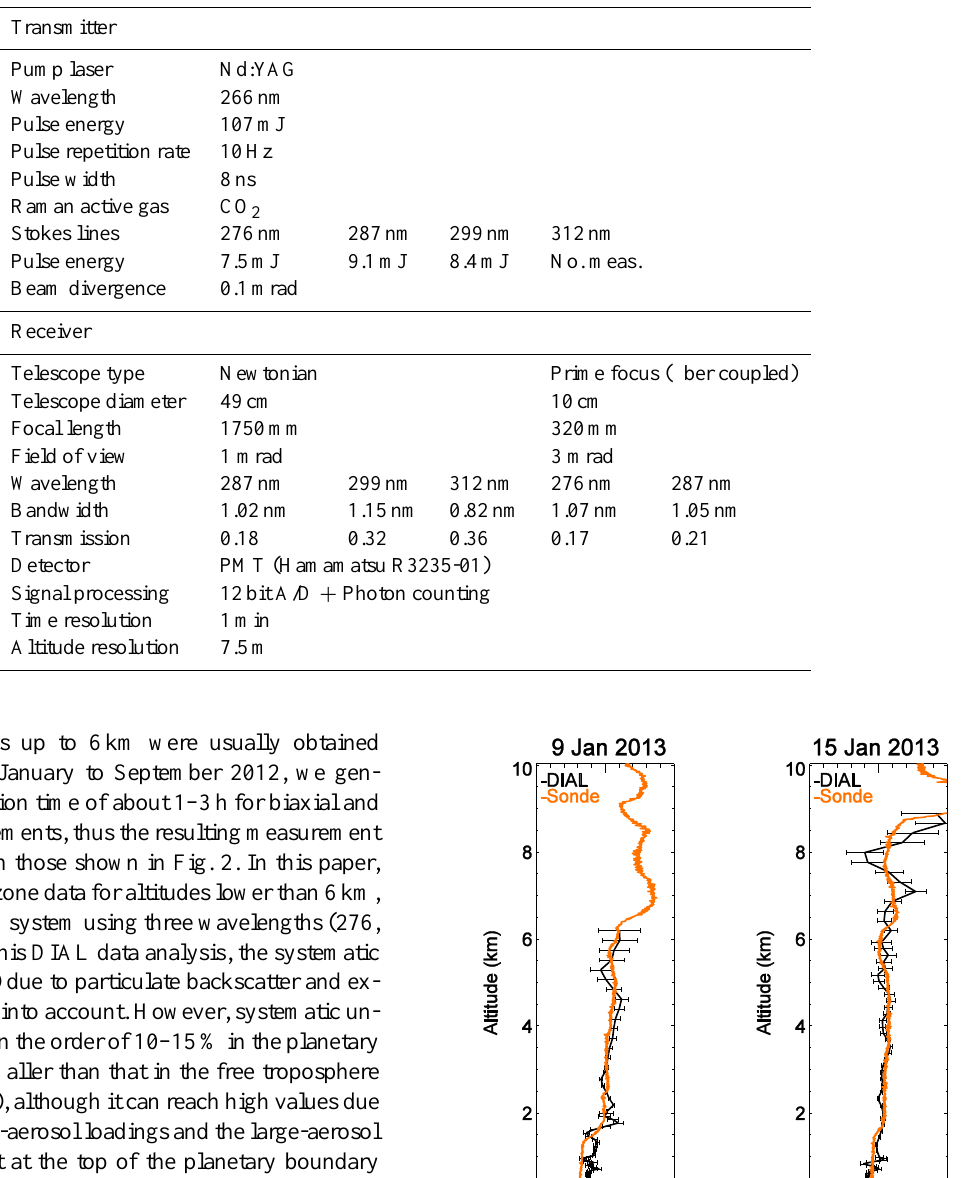
Table 1. Characteristics of tropospheric ozone DIAL system.